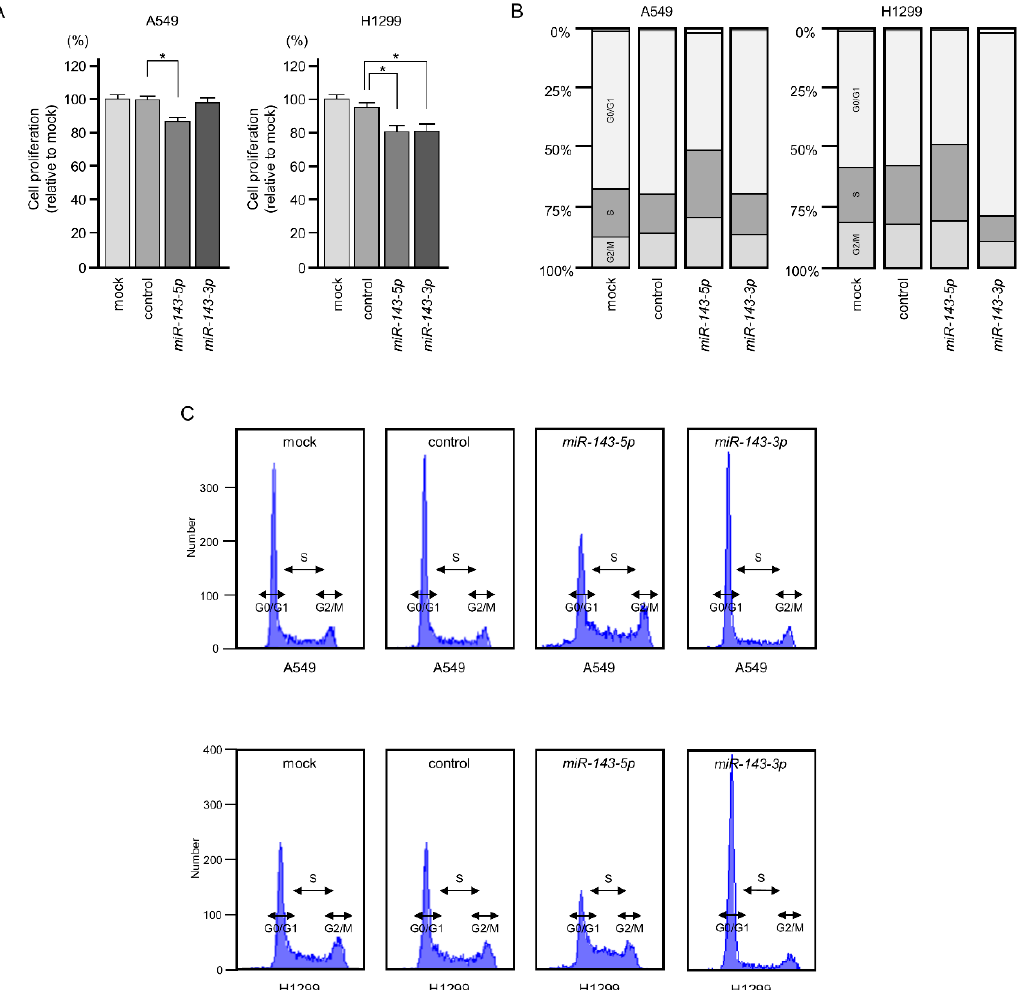
Figure 2. Cell proliferation and cell cycle assays in LUAD cell lines with ectopic expression of miR-143-5p and miR-143-3p . ( A ) Cell proliferation was assessed using XTT assays. Data were measured 72 h after transfection with miRNAs. Cell proliferation was suppressed by miR-143-5p and miR-143-3p in H1299 cells (* p < 0.001), but it was not affected by miR-143-3p transfection into A549 cells. ( B,C ) Cell cycle assays by flow cytometry showed that G 2 /M phase arrest was induced following miR-143-5p transfection into A549 and H1299 cells. In contrast to miR-143-5p transfection, G 0 /G 1 phase arrest was detected by miR-143-3p transfection.